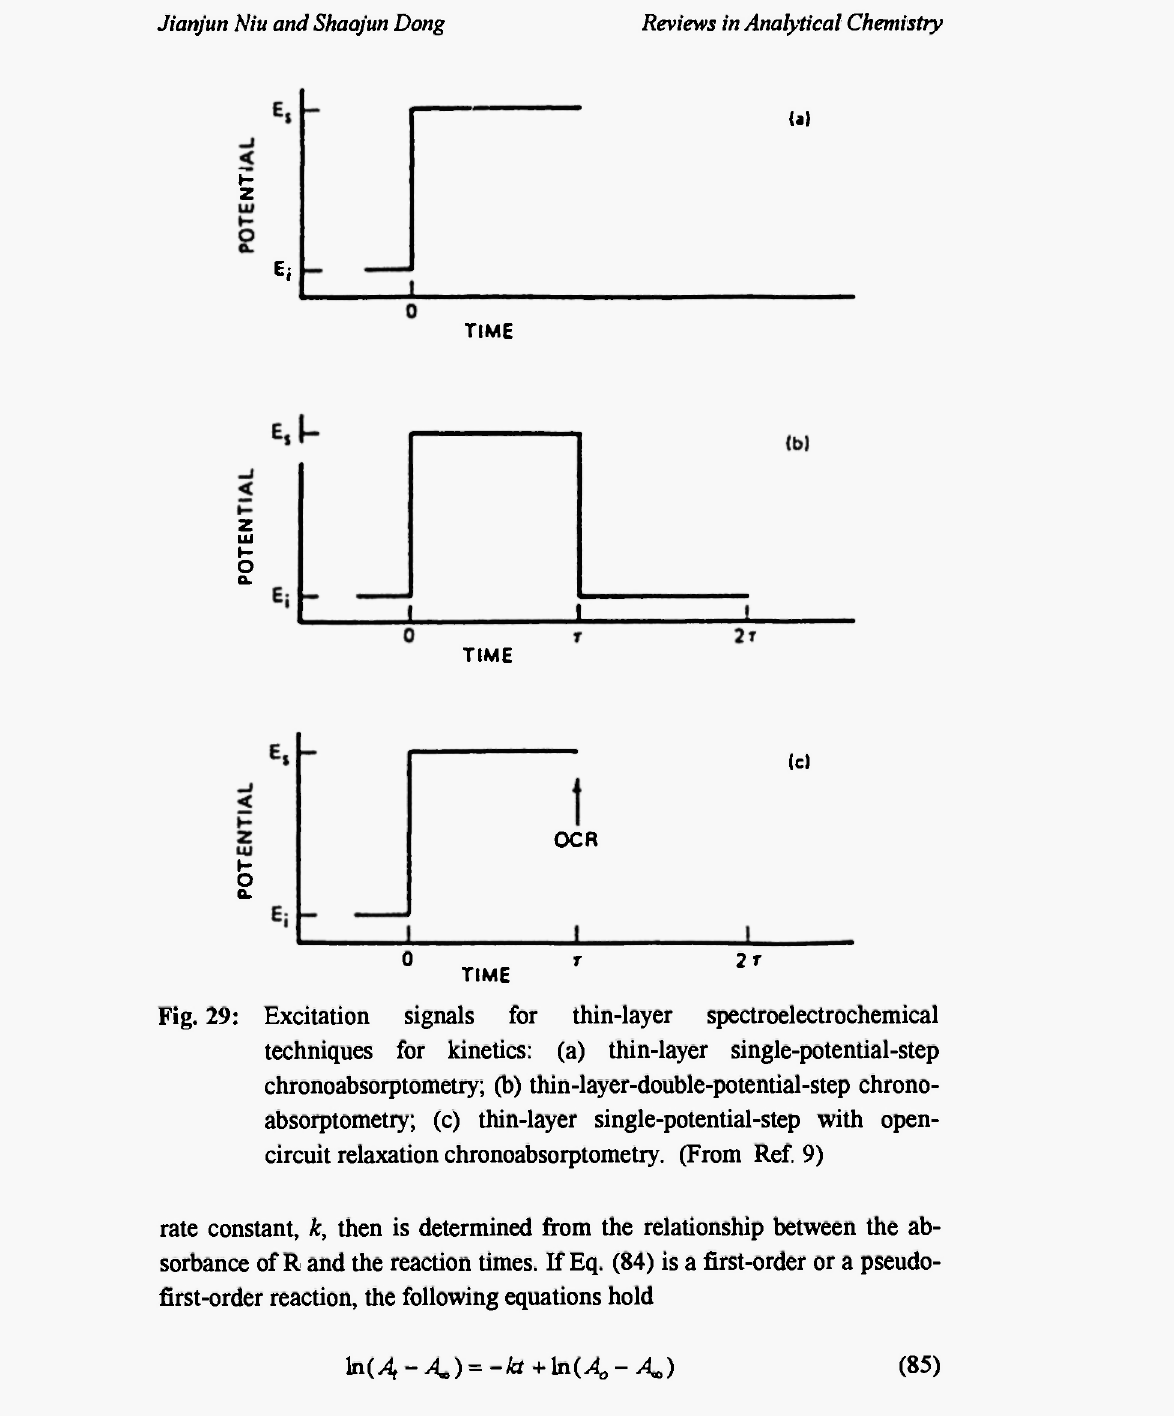
Fig. 29: Excitation signals for thin-layer spectroelectrochemical techniques for kinetics: (a) thin-layer